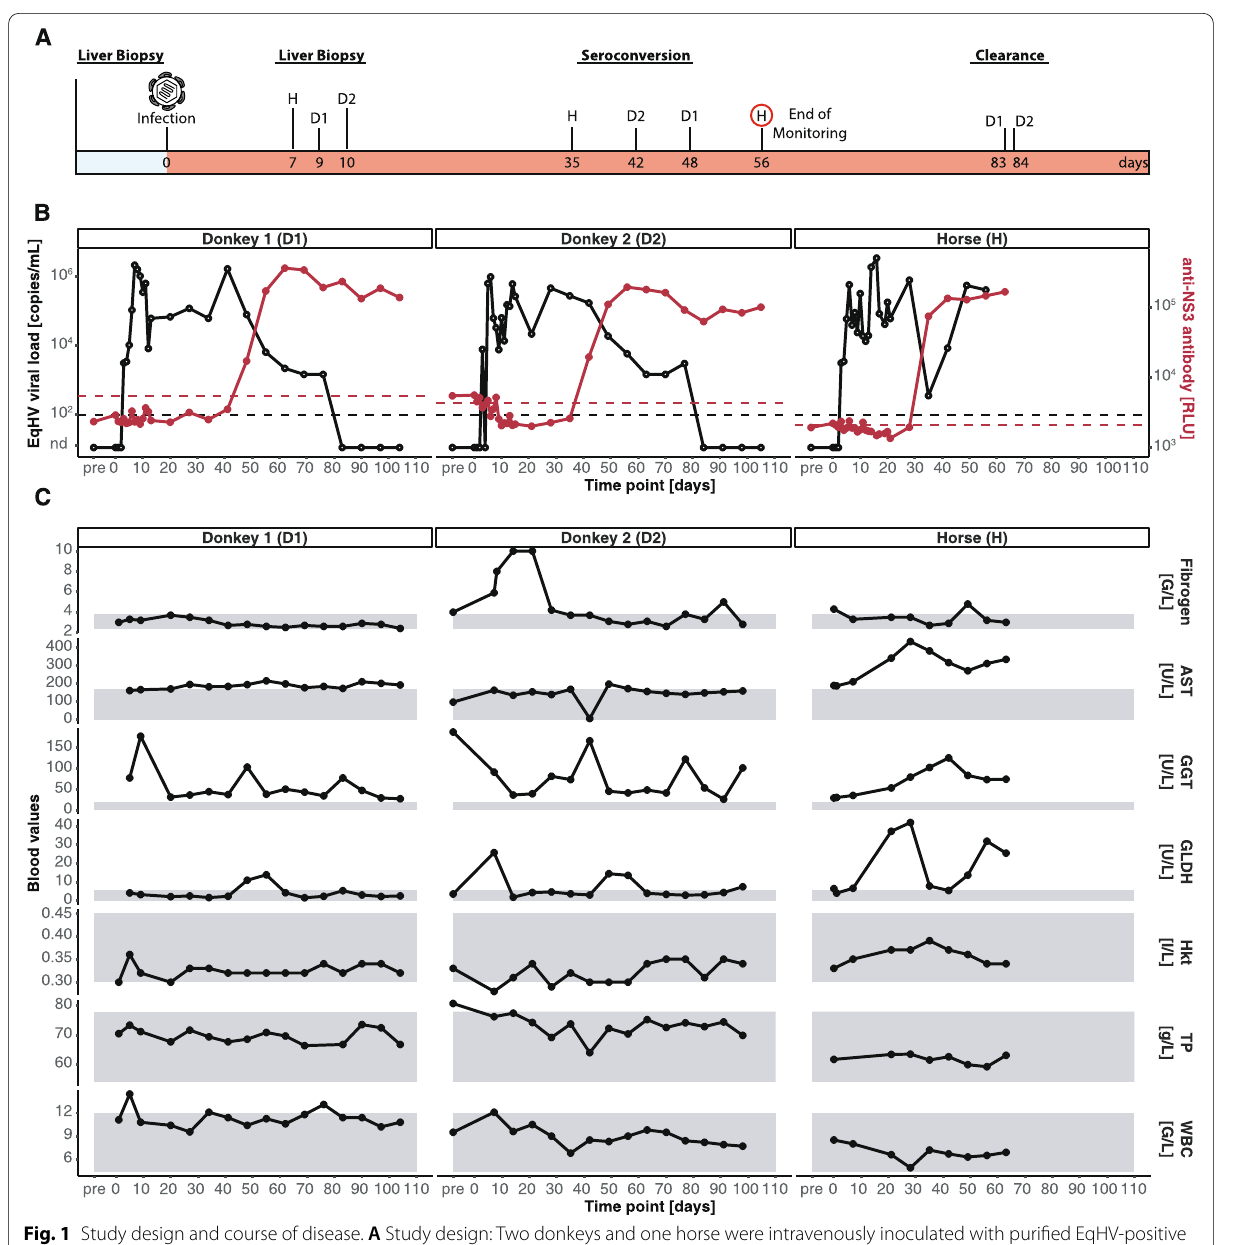
Fig. 1 Study design and course of disease. A Study design: Two donkeys and one horse were intravenously inoculated with purified EqHV-positive serum. B EqHV genome equivalents (black line) and anti-NS3 antibody course (red line) during the observation period. C Plasma levels of fibrinogen (G/L), aspartate transaminase (AST, U/L), gamma-glutamyl transferase (GGT, U/L), glutamatdehydrogenase (GLDH, U/L), hematocrit (Hkt, I/L), total protein (TP, g/L), and white blood cell counts (WBC, G/L). Reference intervals are indicated in